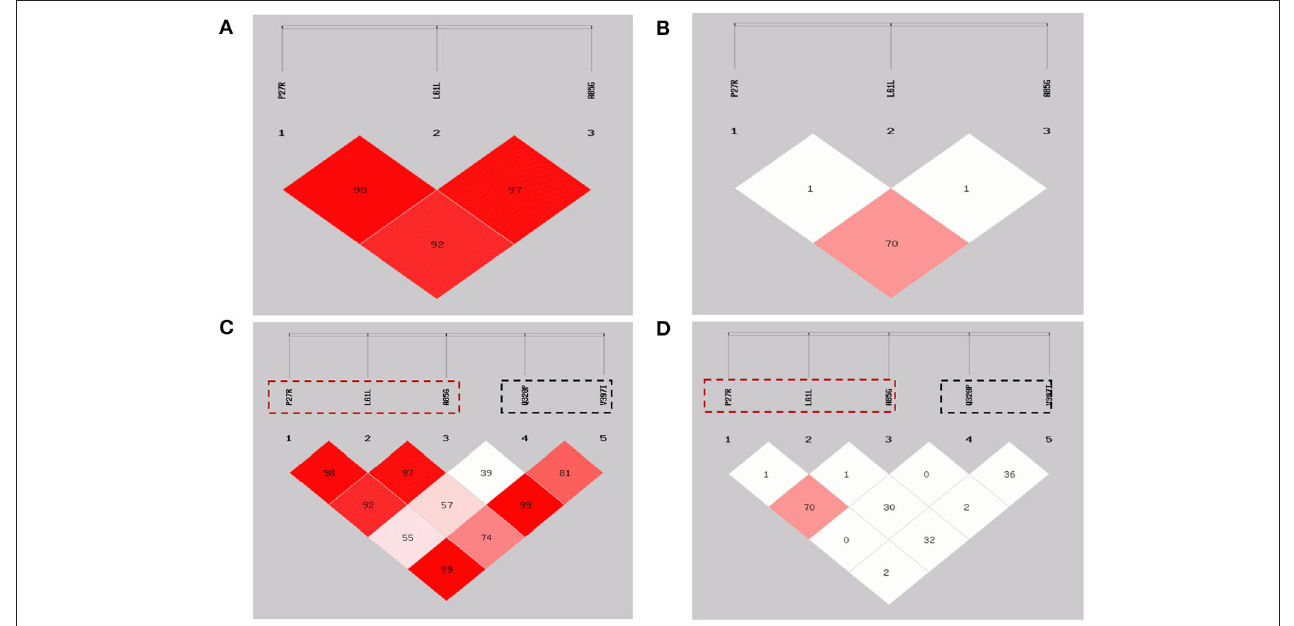
FIGURE 2 | Linkage disequilibrium plots of the GDF9 gene in Shaanbei white cashmere (SBWC) goats. (A,C) : D ′ of SBWC goats; (B,D) : r 2 of SBWC goats. The three loci in the red dotted box were detected in this study and the two loci in the black dotted box were detected in our previous study.